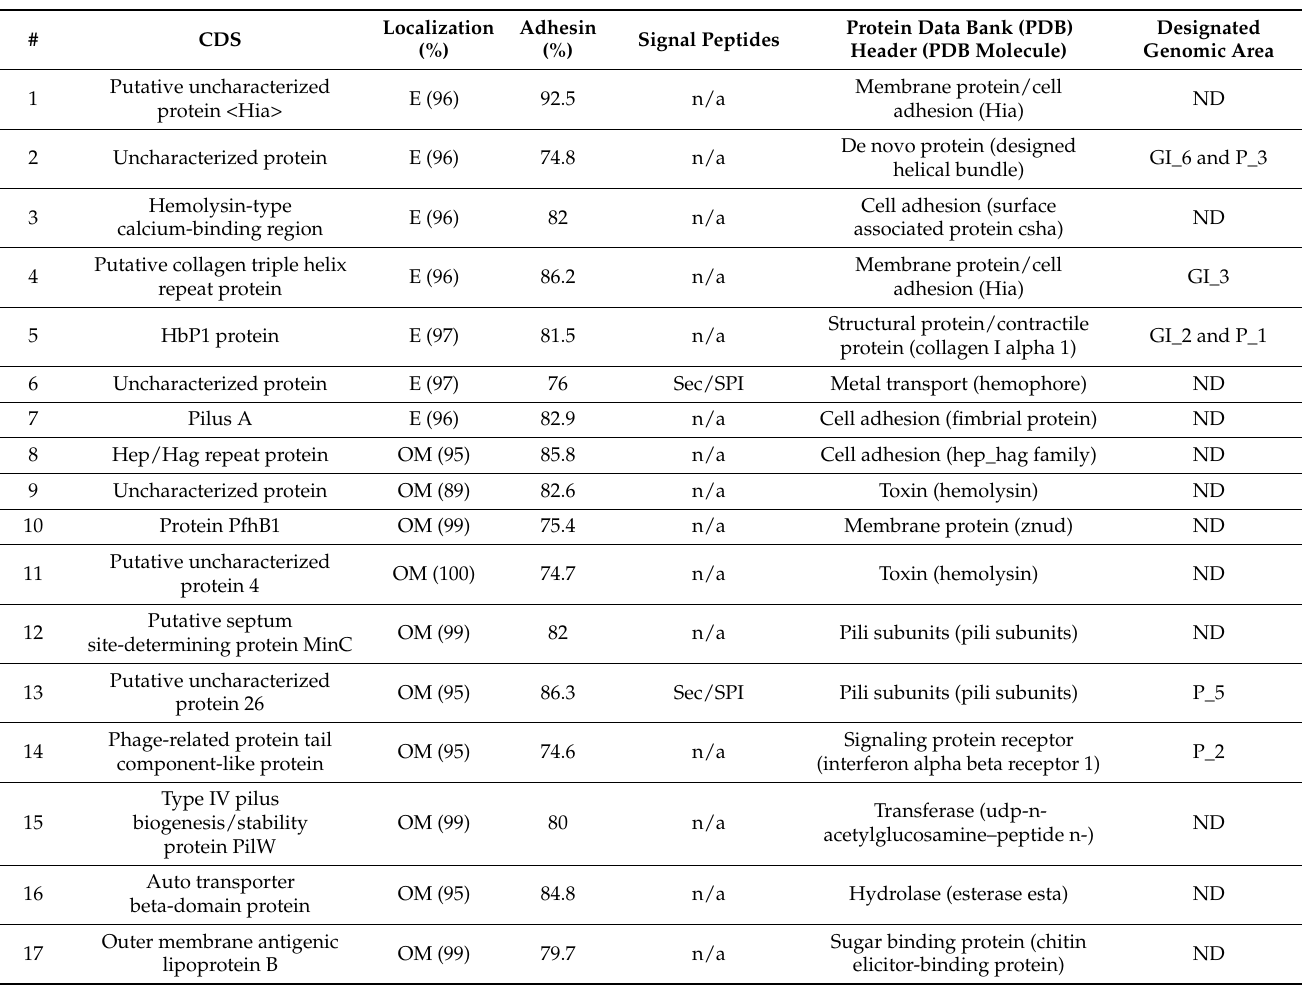
Table 5. Seven extracellular and ten outer membrane localized putative virulence factors of the genome of P. atlantica (NVI 9100). E: extracellular, OM: outer membrane, GI: Genomic island, P: Prophage, and ND: Not